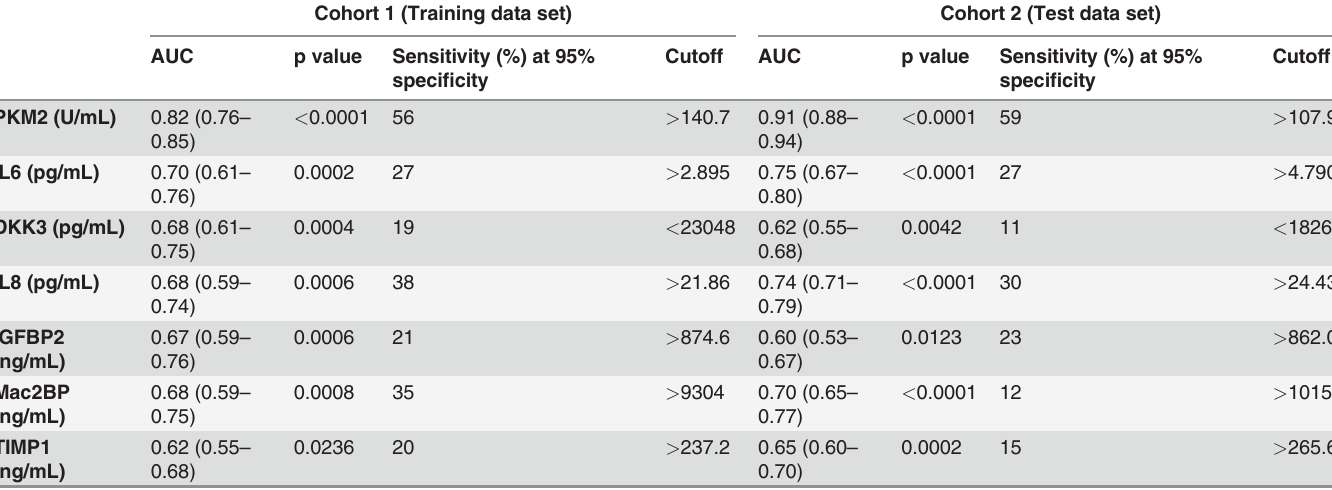
Table 3. Classi fi cation performance of the seven protein biomarkers in the training and test cohorts. Cohort 1 (Training data set)